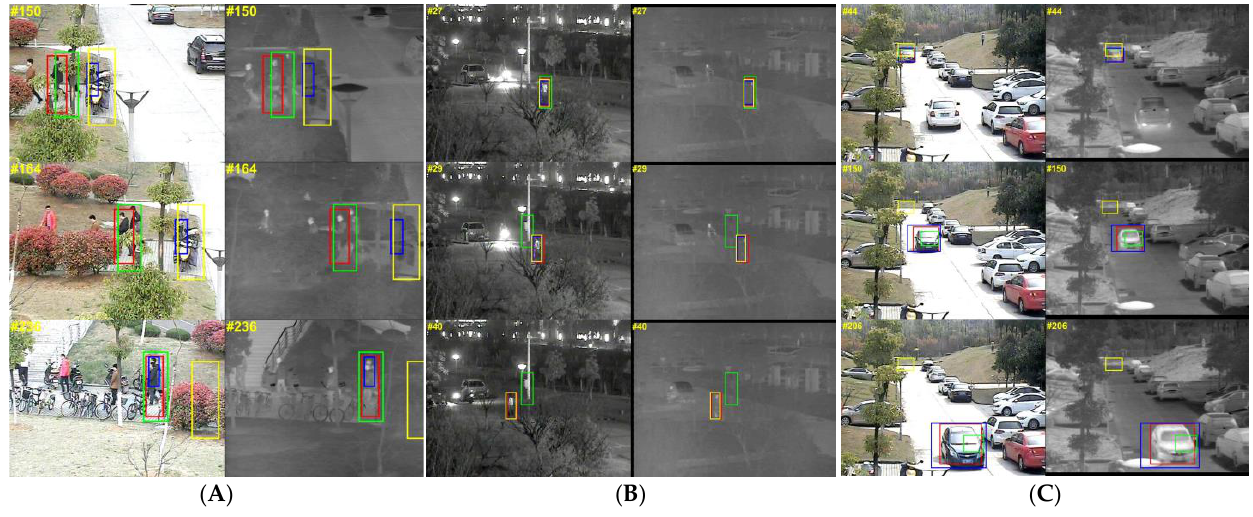
Figure 7. The different colored boxes in the figure correspond to different trackers: the red box is the result box of our tracker, the green box is SGT, the blue box is C-COT, and the yellow box is ECO. ( A ): Results of sequence greyman; ( B ): results of sequence woman6; ( C ): results of sequence car66.